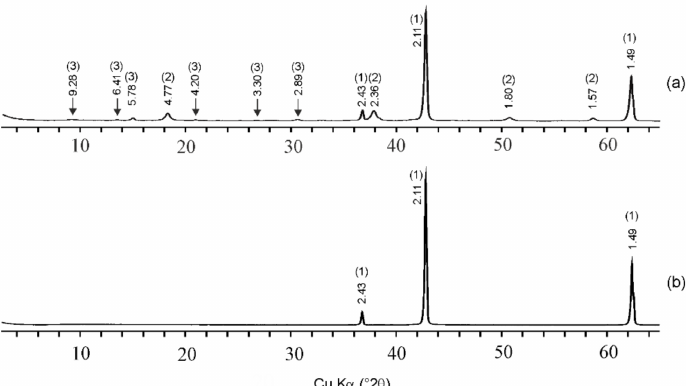
Figure 2. X-ray diffraction patterns of MgO ( a ) and calcined MgO ( b ). 1—MgO (periclase); 2— Mg(OH) 2 (brucite), 3—Mg 5 (CO 3 ) 4 (OH) 2 × 4H 2 O